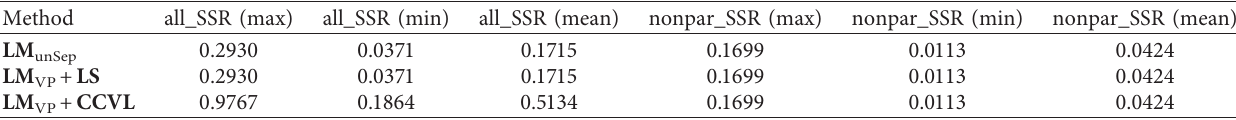
Table 2: Sum of the squared residuals between the estimated parameters obtained using the three methods and the true values in Example 1. Method